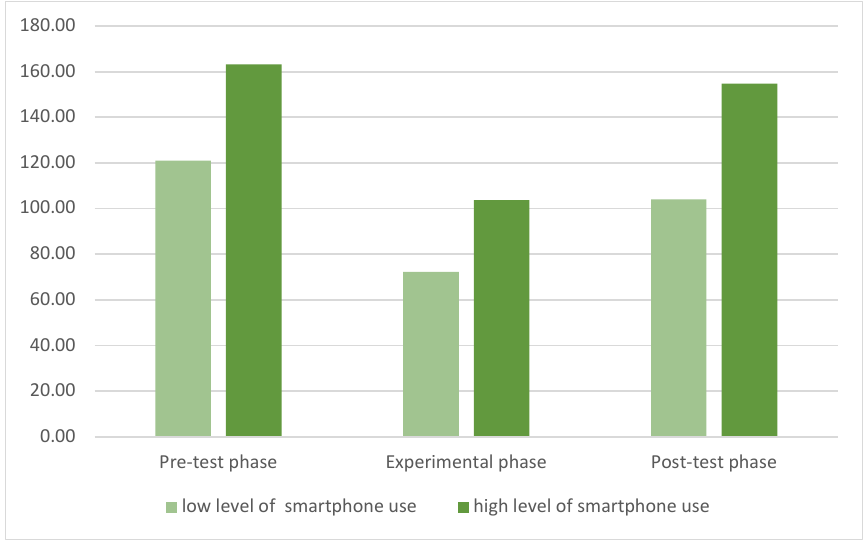
Figure 5. Means of total minutes of smartphone use in the three phases.